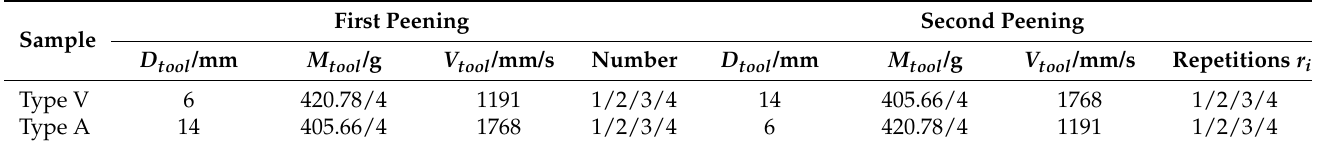
Table 3. Parameter of finite element